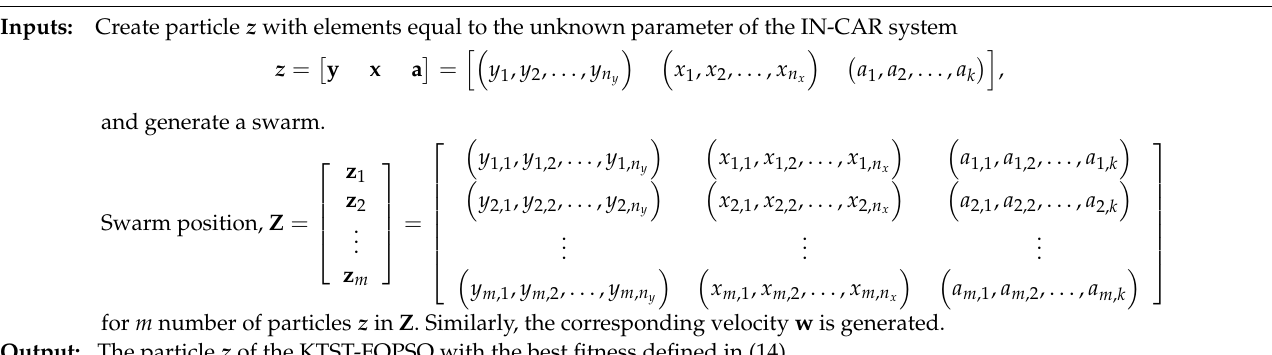
Algorithm 1: Pseudocode of the KTST-FOPSO for parameter estimation of the IN-CAR